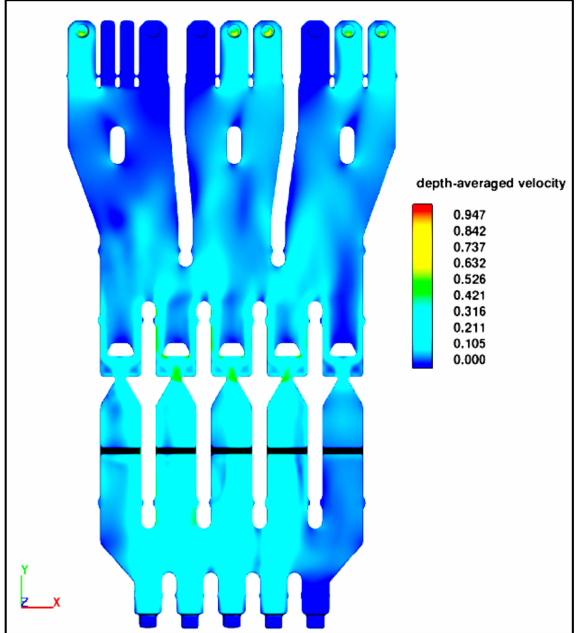
Figure 5. Velocity contours at the basin for scenario I—3D